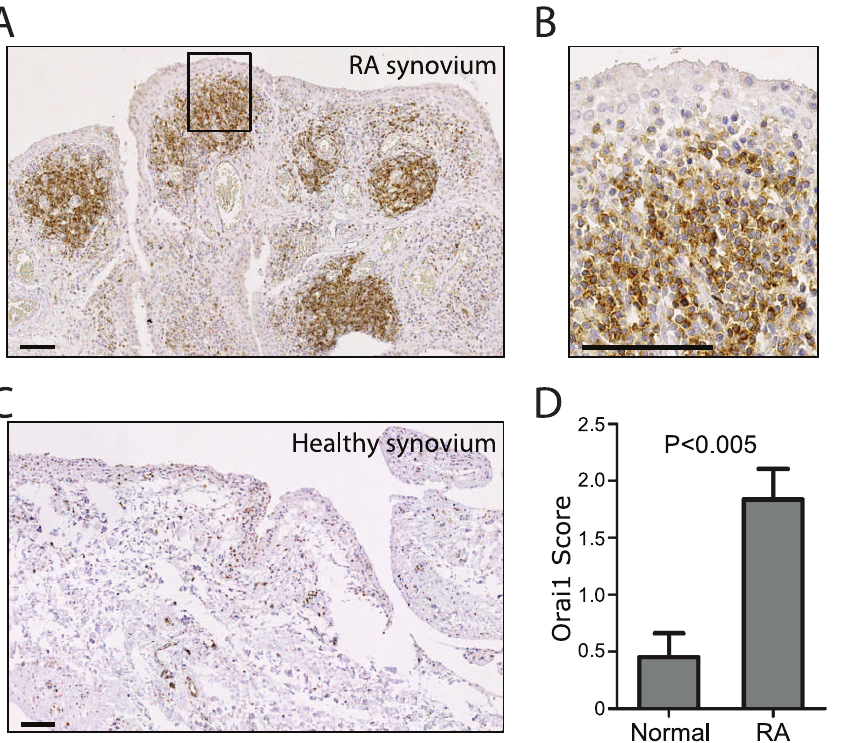
Figure 5. Orai1 expressing cells are abundant in synovial tissue from patients with rheumatoid arthritis. Sections of synovial tissue from patients with rheumatoid arthritis or healthy controls were stained for Orai1 by immunohistochemistry with rabbit anti-Orai1 (Sigma), and the number of Orai1-positive immune cells was evaluated by assigning each stained tissue section a semi-quantitative score ranging from 0–4. A ) Orai1 immunohistochemistry of rheumatoid arthritis synovial tissue. B ) Magnification of A. C ) Orai1 immunohistochemistry of normal synovial tissue. D ) Histogram showing mean semi-quantitative scores of the number of Orai1-positive cells in synovial tissue from rheumatoid arthritis patients (RA) (n=24) or normal synovial tissue (n=11). Error bars, + / 2 SEM. Scale bars, 100 m m.